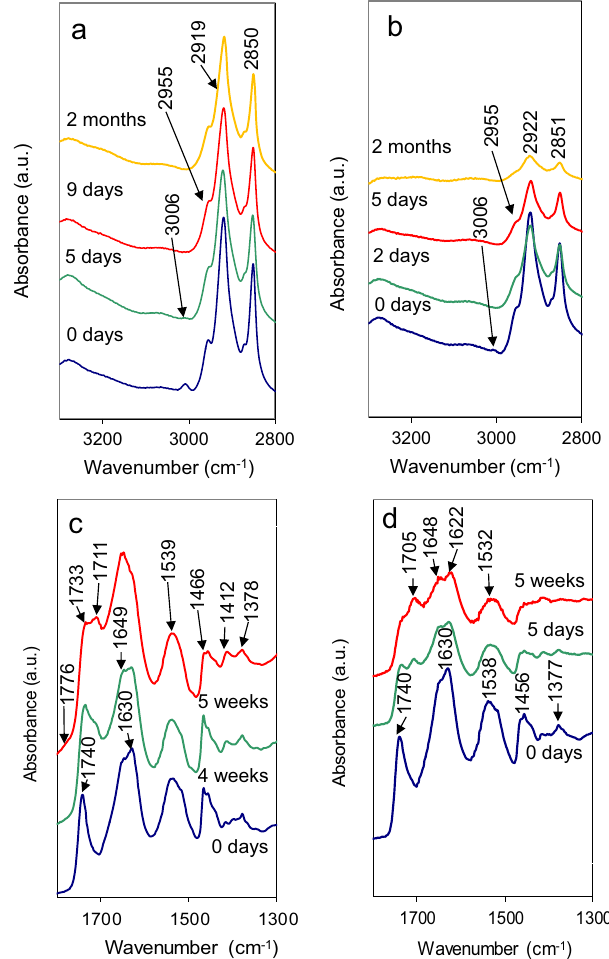
Fig. 7 ATR-FTIR spectra of pure egg yolk and cinnabar-based paint. a , c Egg yolk and b , d cinnabar-based paint upon UV aging for different periods of